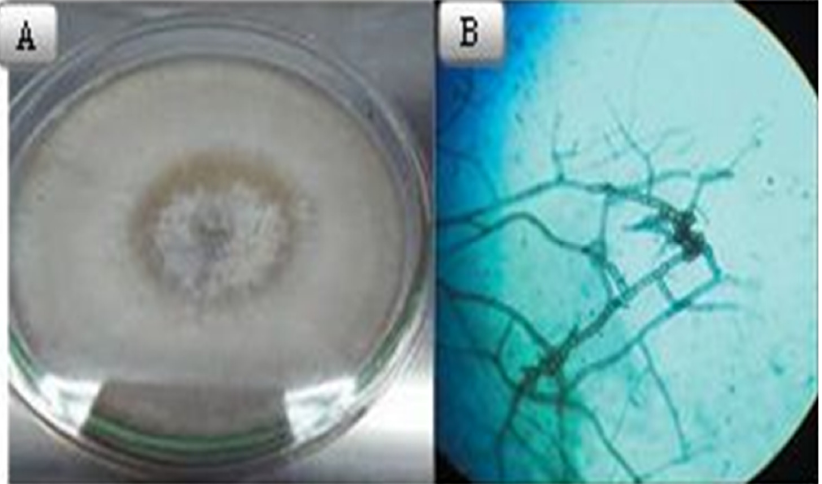
Figure 1. Morphology of Rhizoctonia solani. A : Pure culture of R. solani isolated from diseased Irish tuber. B : Photomicrograph of R. solani